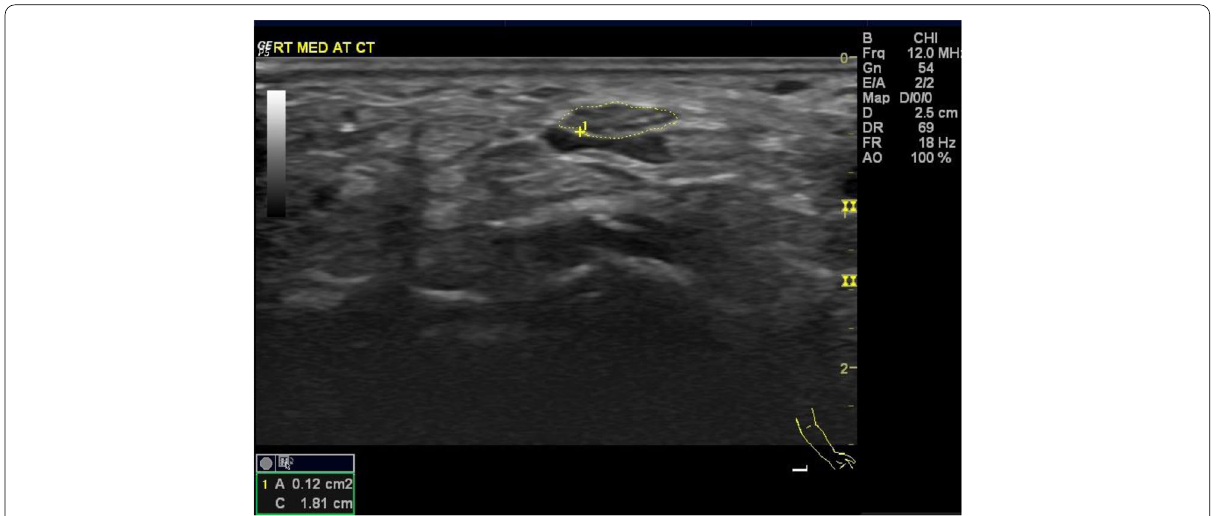
Fig. 5 Patient with disease activity score (DAS28) cross‑sectional area (CSA) (12mm 2 )